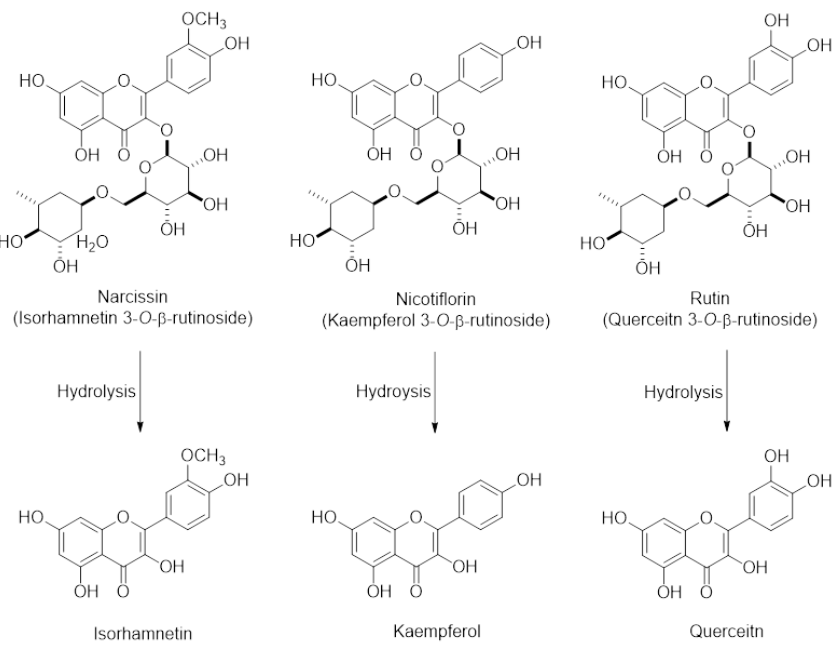
Figure 1. The chemical structures of major flavonoids in the forms of glycosides and their respective aglycones present in Opuntia ficus indica fruit extract (OFIE); Narcissin, nicotiflorin, and rutin are the 3- O -rutinosides of isorhamnetin, kaempferol, and quercetin, respectively.